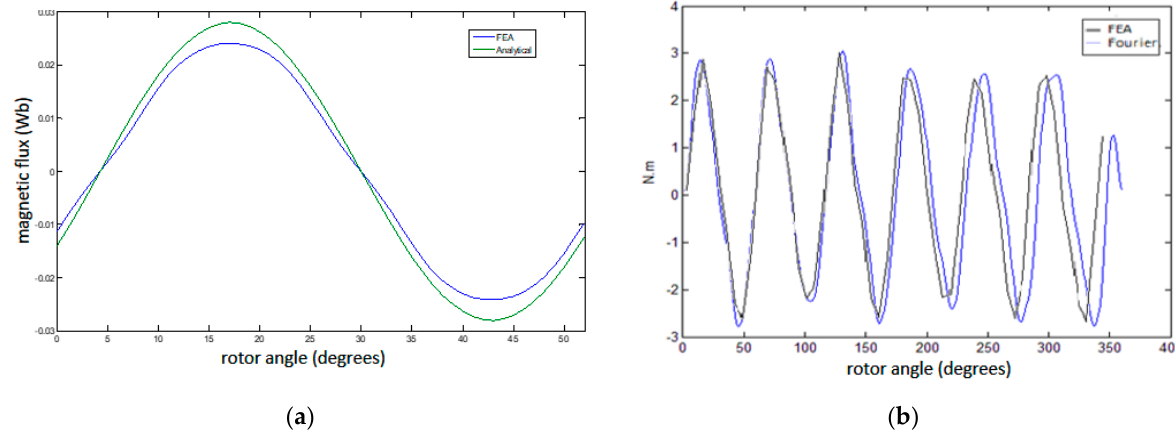
Figure 5. ( a ) Flux linkage: comparison of FEA and analytical flux linkage as a function of the rotor angle. ( b ) Cogging torque: comparison of FEA and Fourier representation.